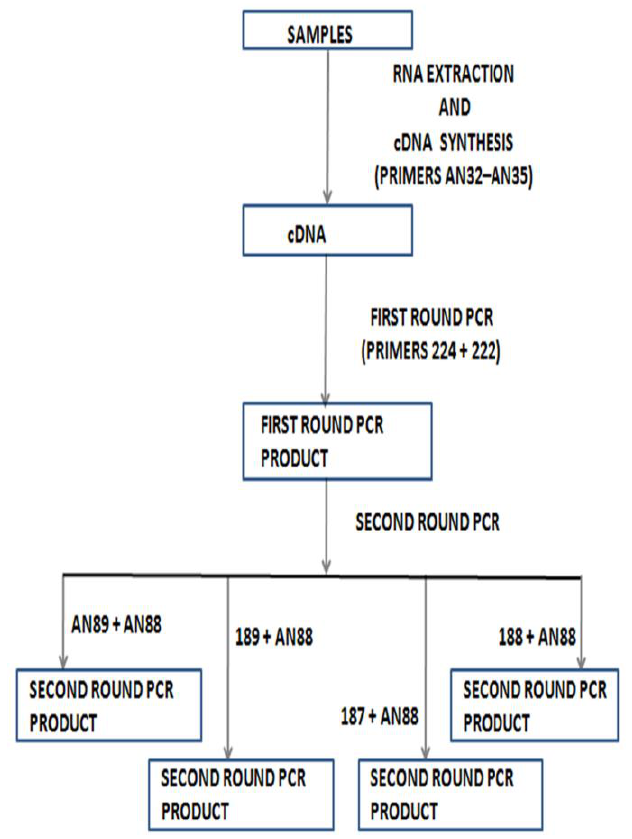
Figure 3. Modified WHO algorithm used in our laboratory for direct detection of enteroviruses from clinical specimens.